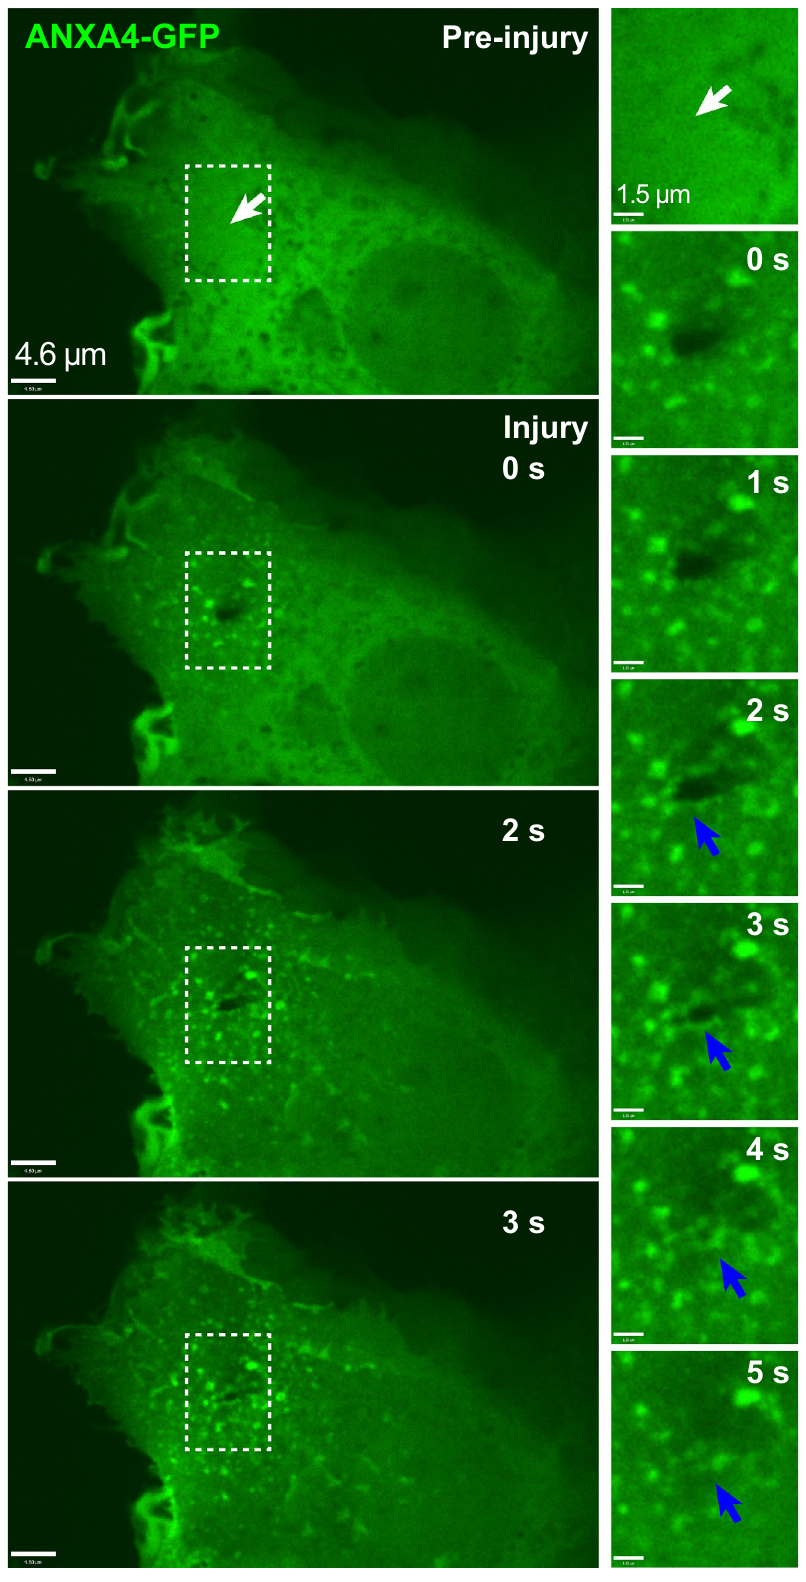
Figure 7. Sequential images of MCF7 cell expressing ANXA4-GFP and exposed to laser injury by shooting through the plasma membrane by laser at the injury site (white arrow). A zoom of the injury region shows that ANXA4-GFP localizes to wound edges (blue arrow) followed by closure of the membrane hole within 5 s after